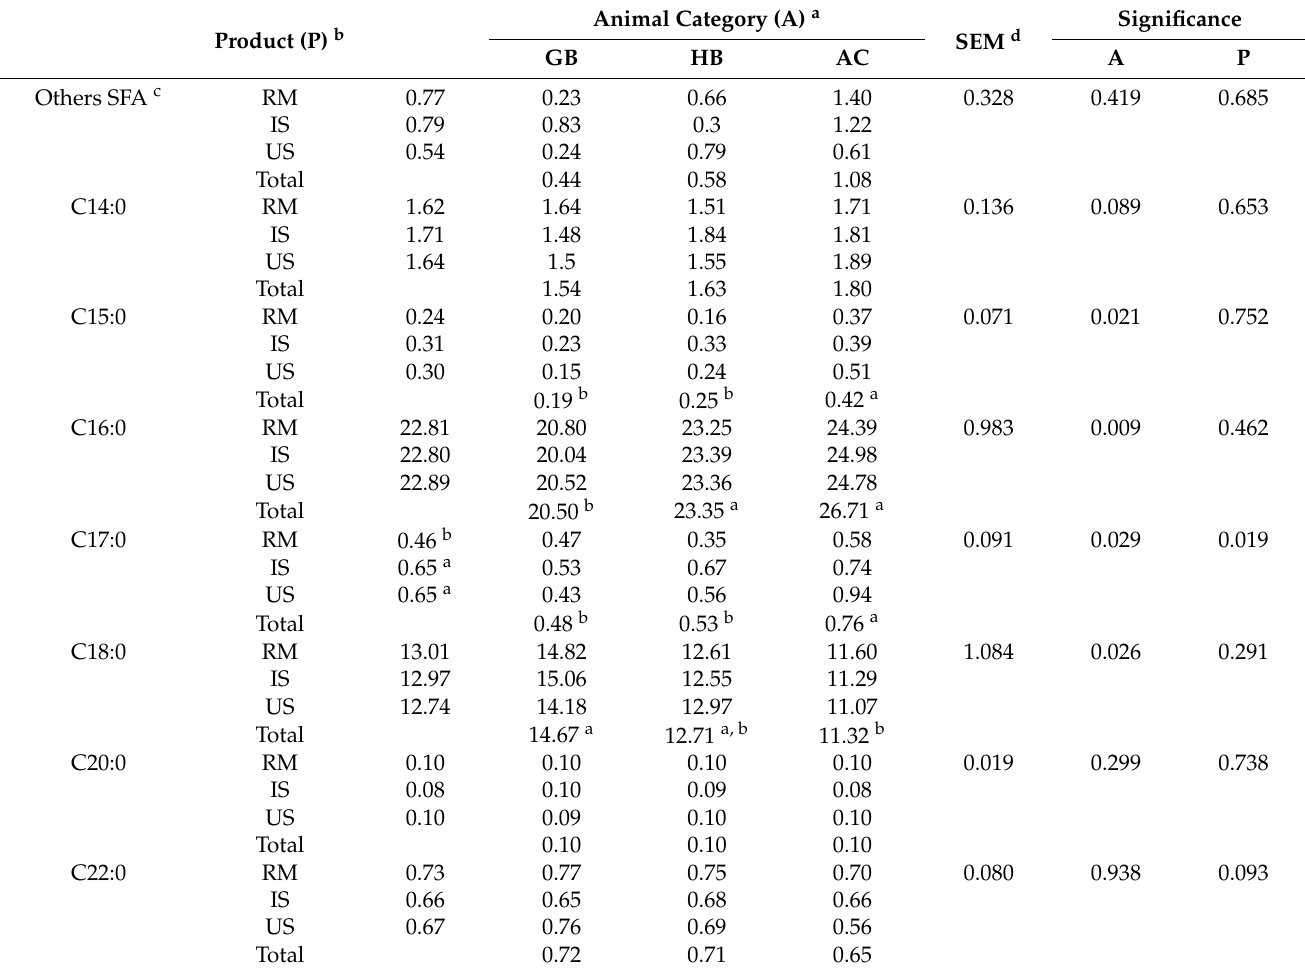
Table 3. Effects of animal category and product on saturated fatty acids (% of total FA) of salami fat. Product (P)